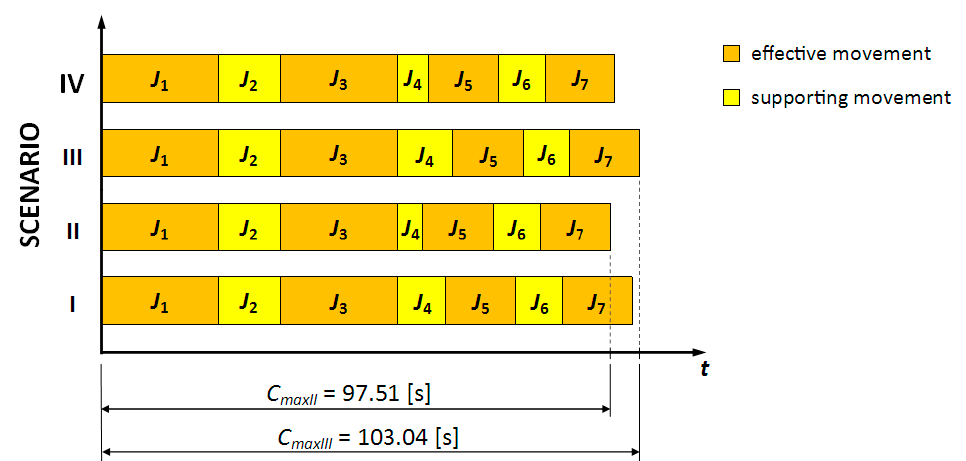
Figure 4. Schedules of the work of the robot in one position for different scenarios.